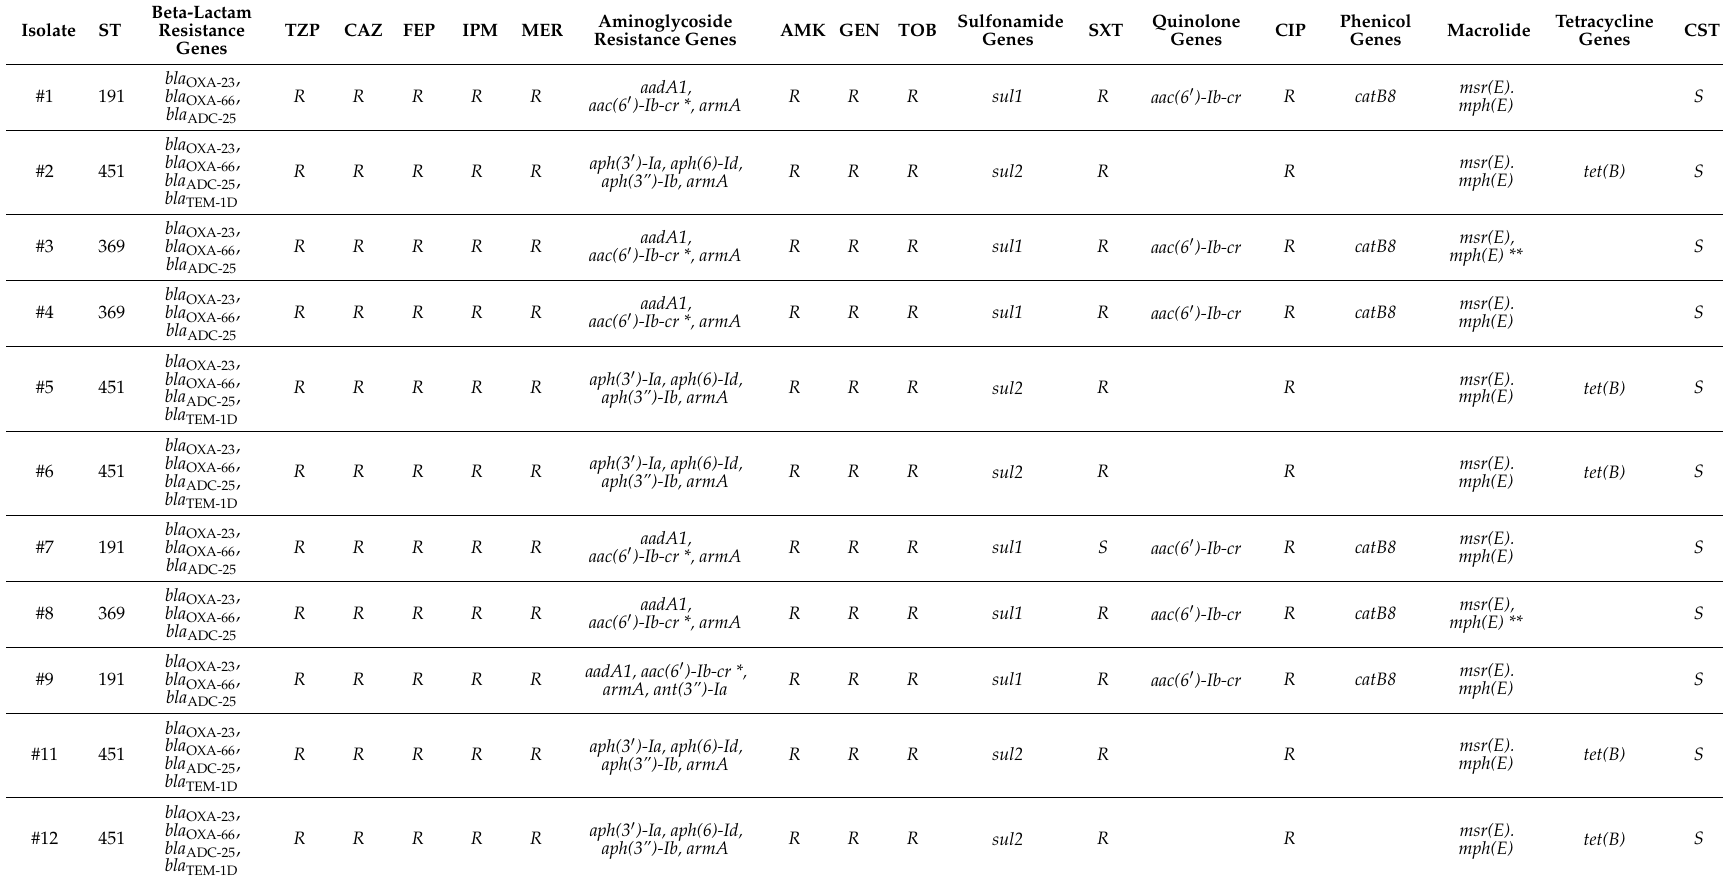
Table 2. In silico detection of resistance determinants of antimicrobial agents and the antibiogram from